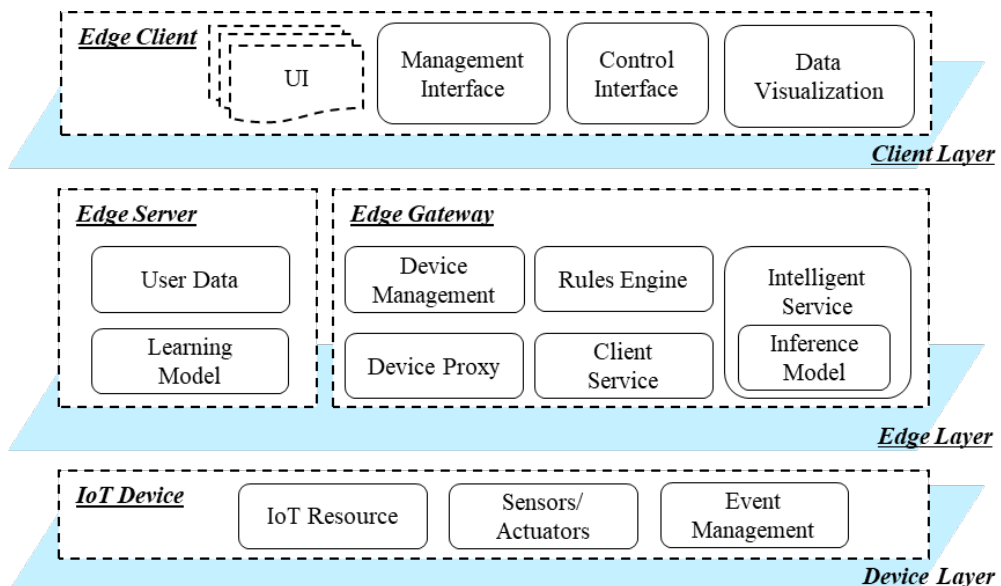
Figure 2. Intelligent edge computing hierarchical architecture.